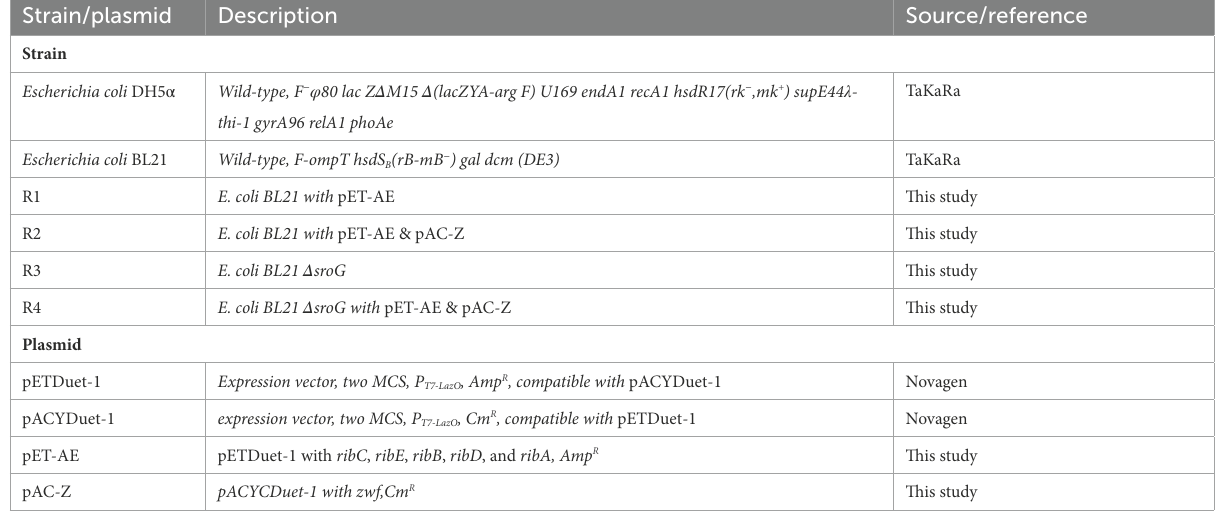
TABLE 1 Strains and plasmids used in this study.